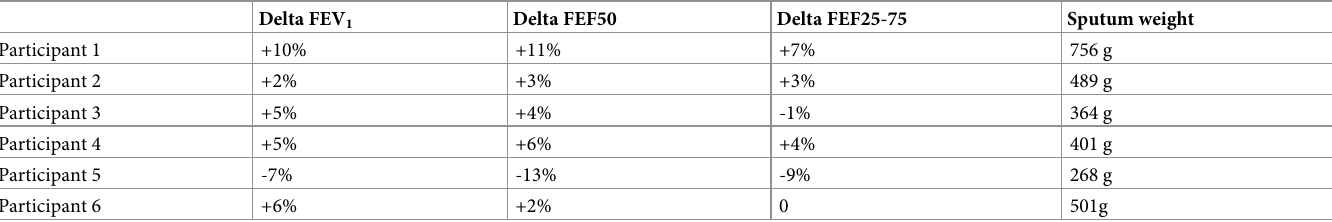
Table 2. Change (delta) in lung function and total sputum weight from Week 1 and to the end of the study in Week 8.